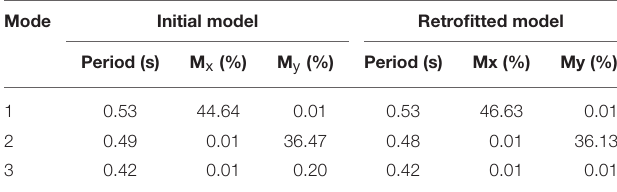
TABLE 2 | Modal analysis results considering SSI effect. TABLE 3 | Characteristics of the ground